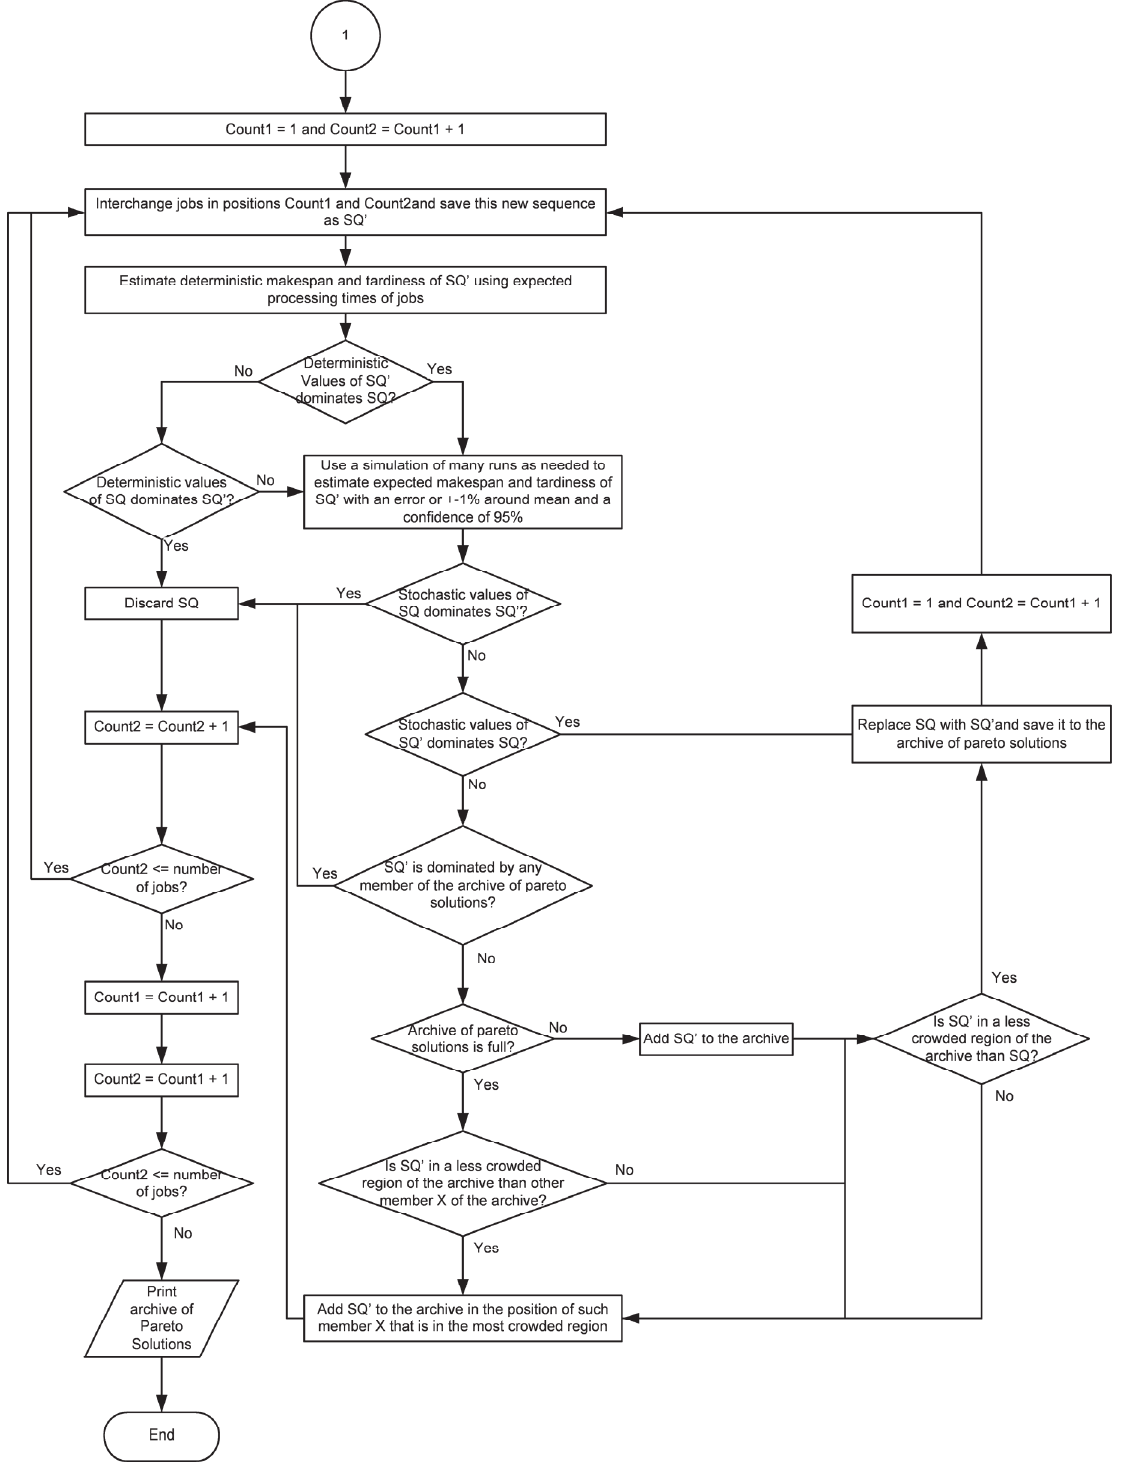
Fig. 3. Flow diagram of Construction phase of